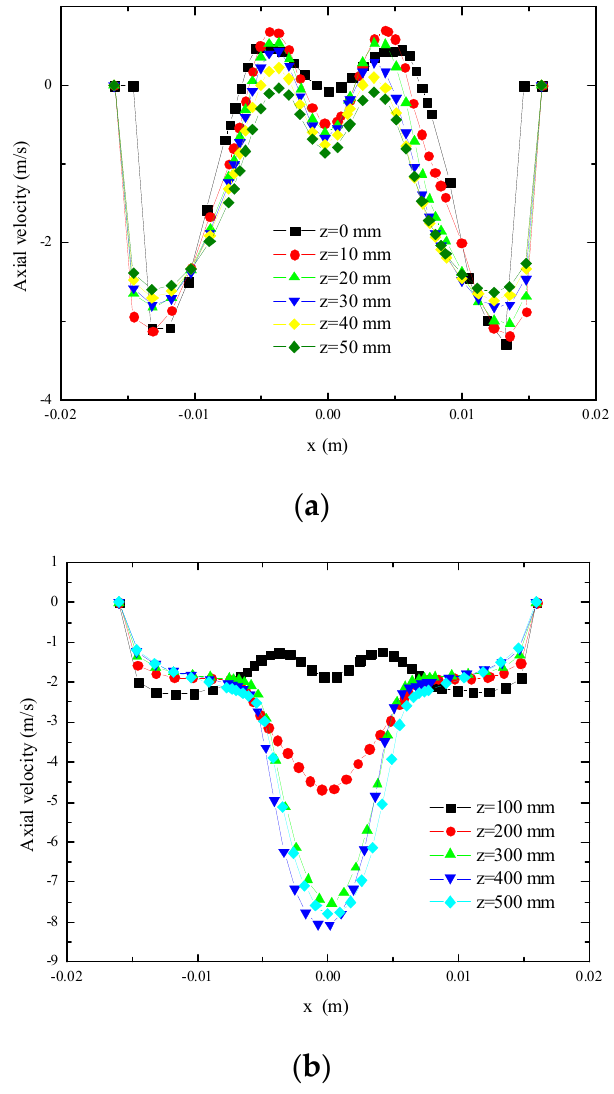
Figure 13. Radial distribution of axial velocity at different positions in the inner cylinder. ( a ) Axial velocity distribution at different positions (within 50 mm); ( b ) Axial velocity distribution at different positions (more than 100 mm).